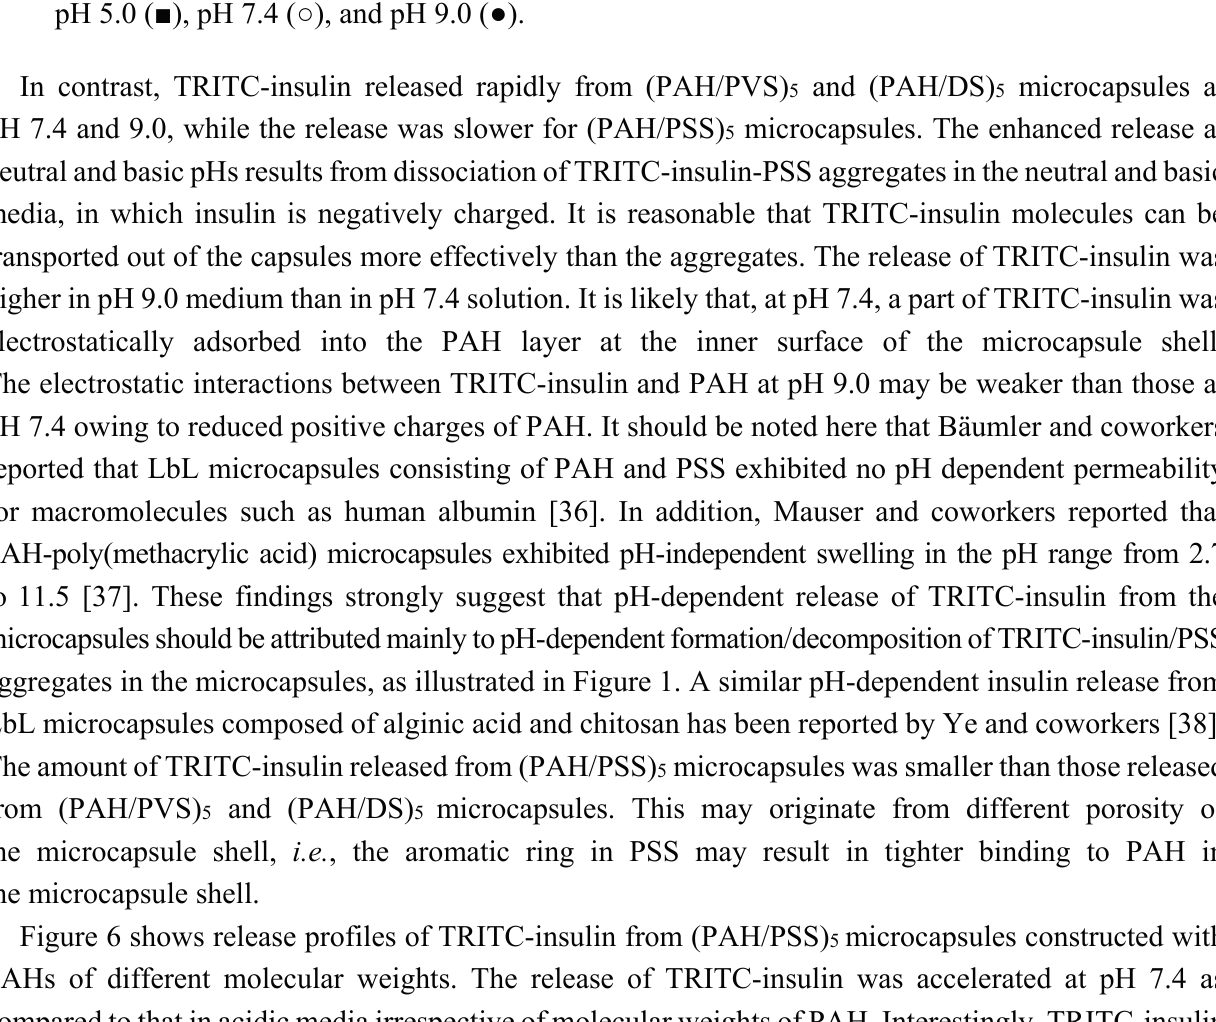
Figure 5. TRITC-Insulin release from (PAH/PSS) 5 ( A ); (PAH/PVS) 5 ( B ) and (PAH/DS) 5 ( C ) microcapsules in the media with different pH. The solution pH was pH 1.4 ( ▲ ), pH 3.0 ( △ ), pH 5.0 ( ■ ), pH 7.4 ( ○ ), and pH 9.0 ( ●